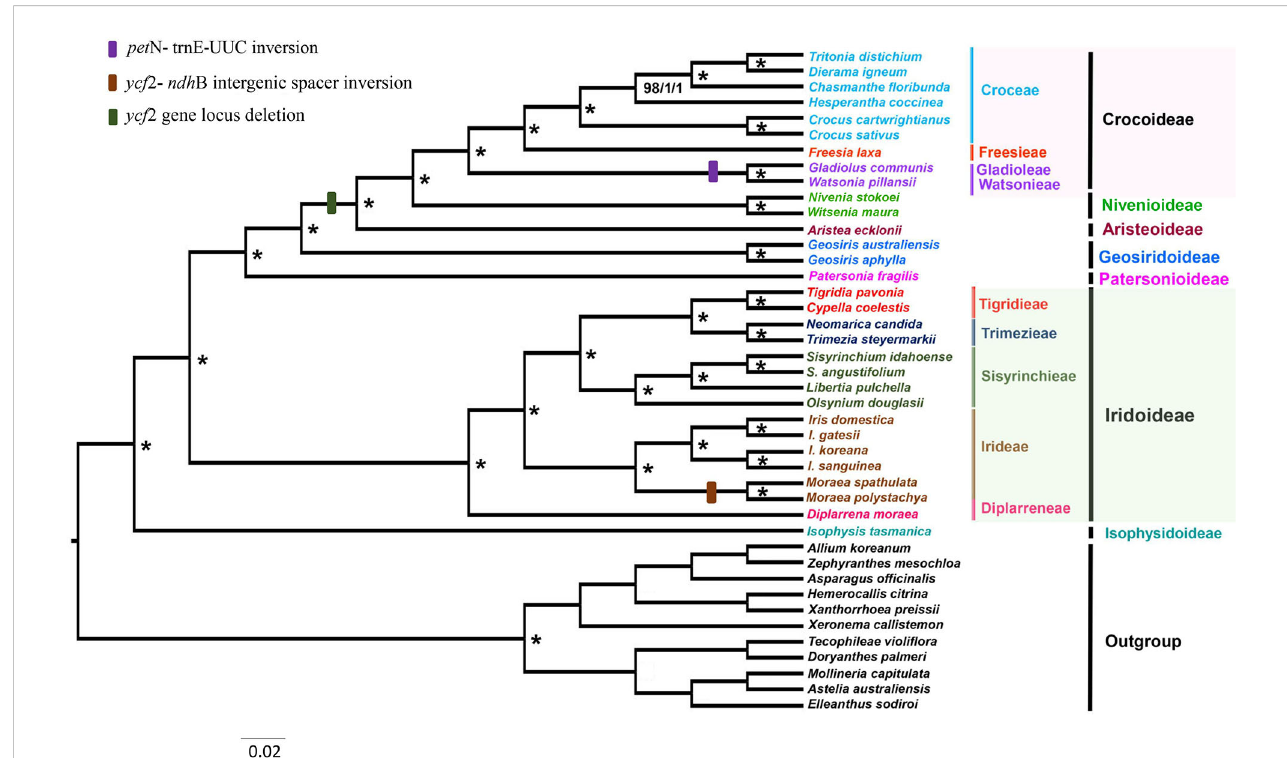
FIGURE 6 Estimated phylogenetic tree of Iridaceae based on maximum parsimony (MP), maximum likelihood (ML), and Bayesian inference (BI) analyses using 79 protein- coding genes. The asterisks (*) around nodes indicate a bootstrap value of 100% for MP and ML analyses and a posterior probability of 1.0 for BI